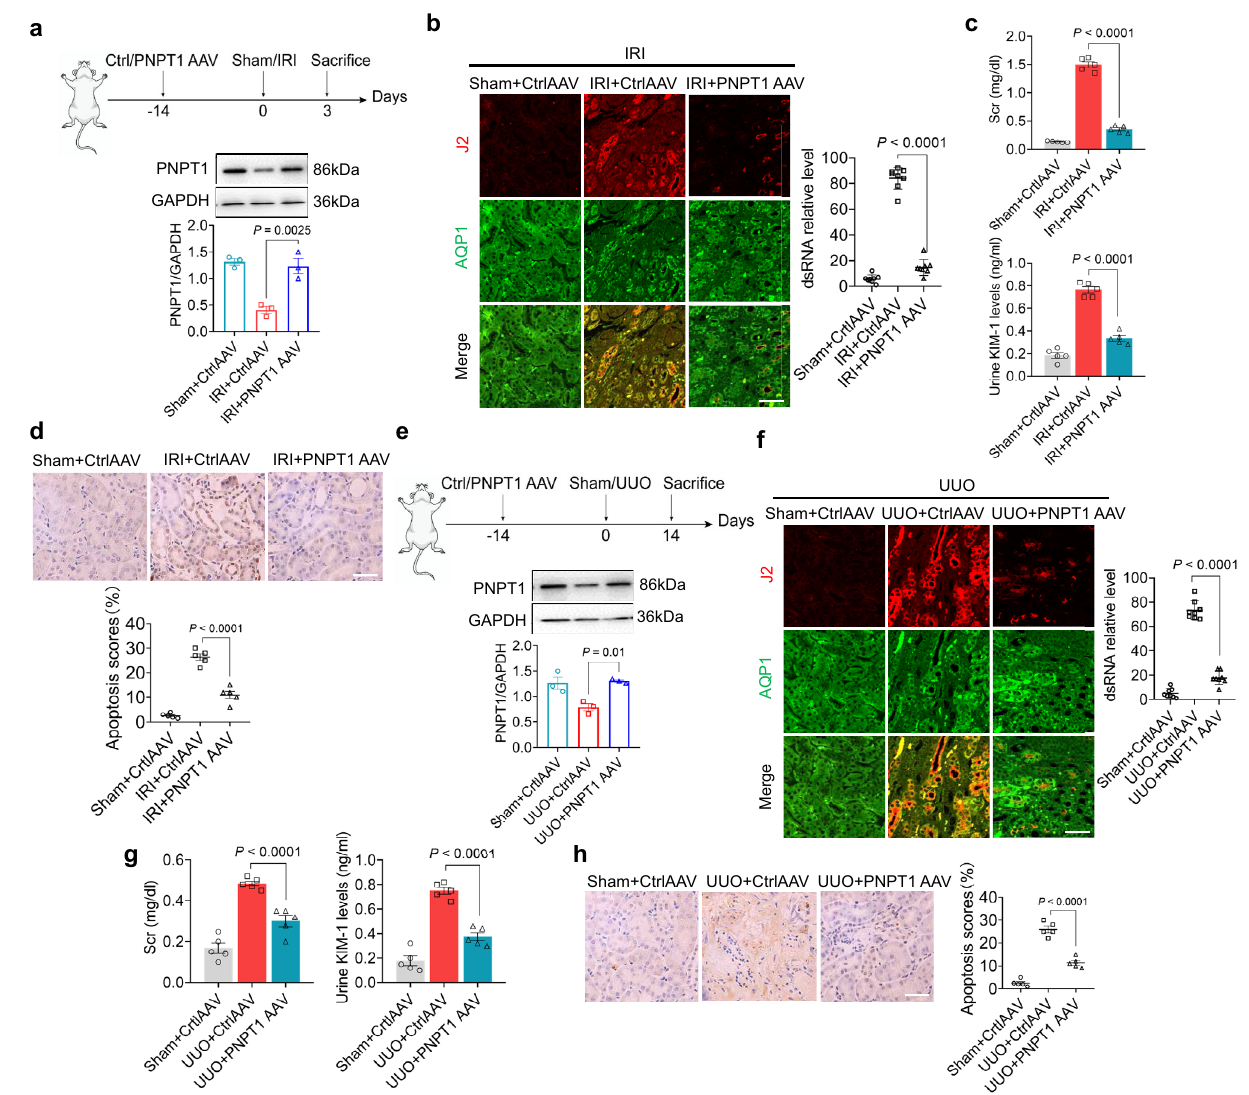
Fig. 5 | Increasing PNPT1 expression in mouse renal tubule attenuated tubular injury. a Top, schematic experimental approach of PNPT1-AAV infection in IRI mouse model. Bottom: WB analysis of renal tubular PNPT1 level (3 mice/group). b Left: renal tubular dsRNA (J2, red) staining in IRI mouse model with or without PNPT1 AAV infection. Right: quanti fi cation of renal tubular dsRNA level (8 mice/ group). c Serum creatinine (top) and urinary KIM-1 levels (bottom) in IRI mouse modelwith or withoutPNPT1AAVinfection(5mice/group). d Top:TUNELassayof renal tubular apoptosis in IRI model mouse with or without PNPT1 AAV infection. Bottom: quanti fi cation of TUNEL assay (5 mice/group). e Top: schematic experi- mental approach of PNPT1-AAV infection in UUO mouse model. Bottom: WB ana- lysisofrenaltubularPNPT1level(3mice/group). f